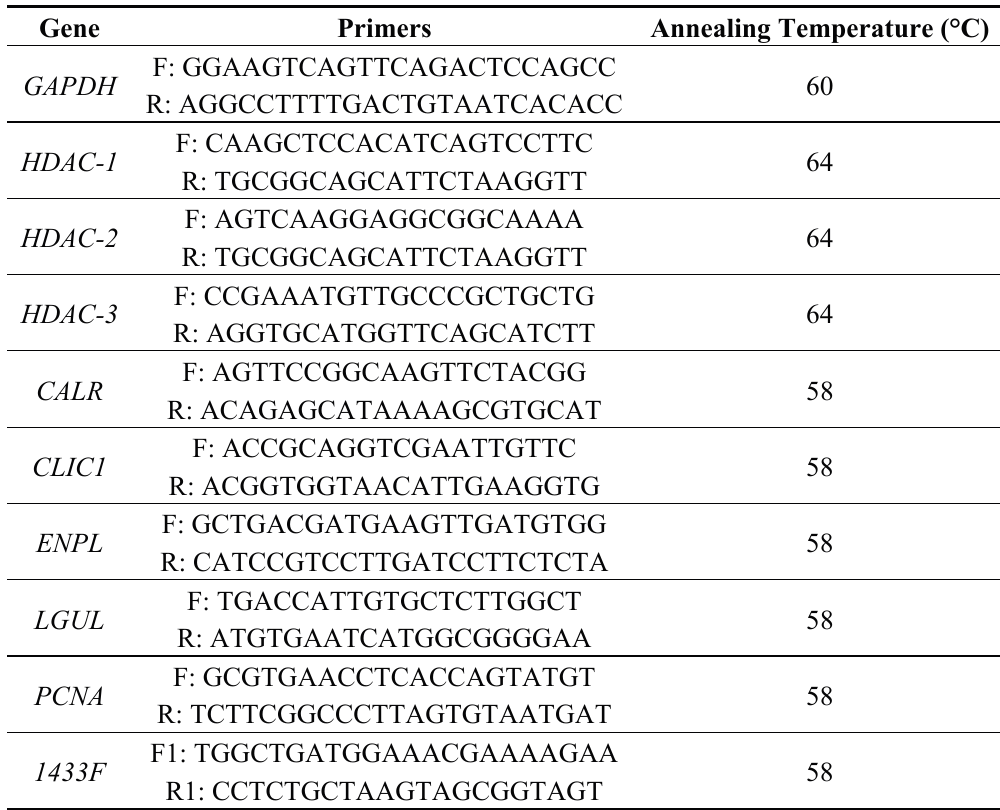
Table 2. Primer sets used for